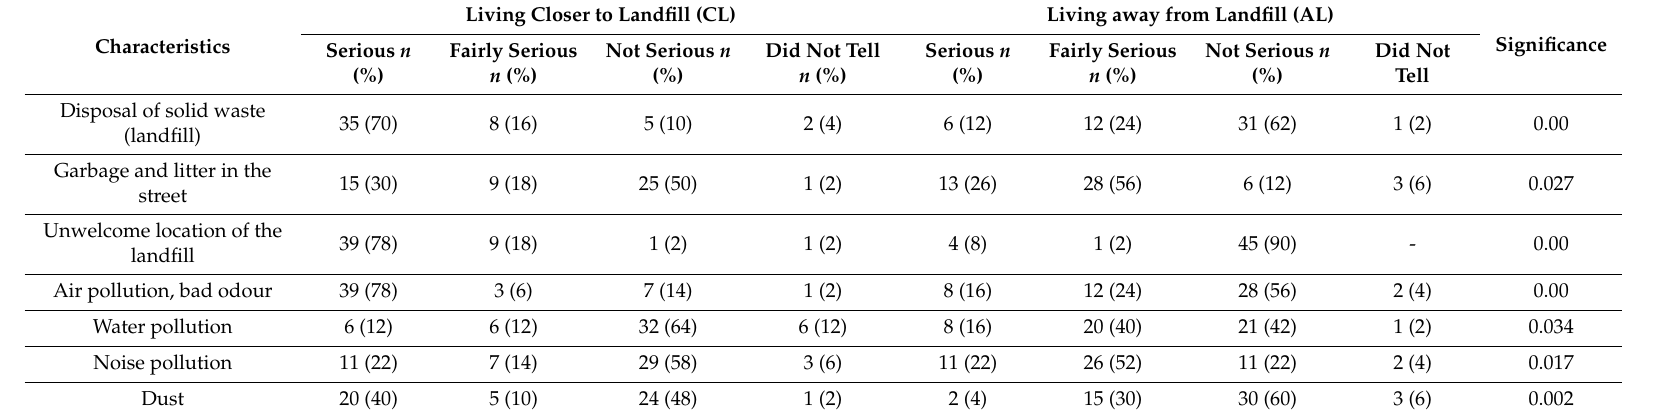
Table 2. Respondents’ rating of the significance of environmental problems in the